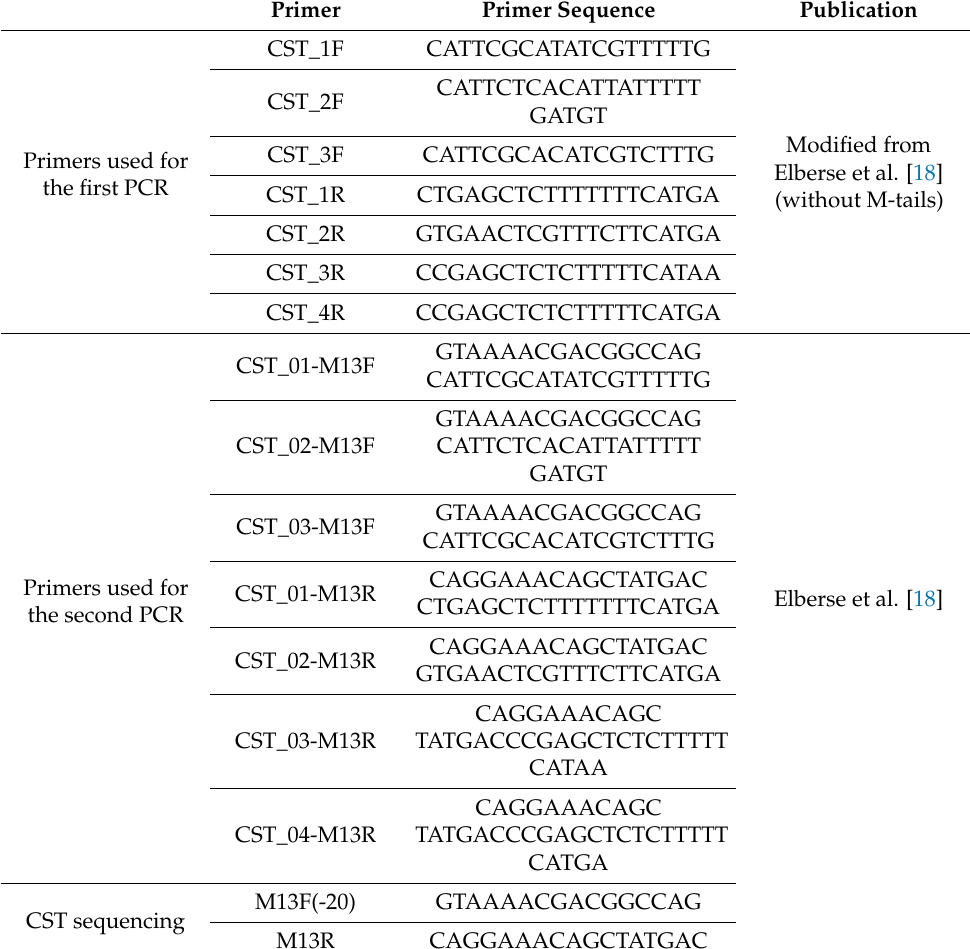
Table 1. Primers’ sequences used for the CST